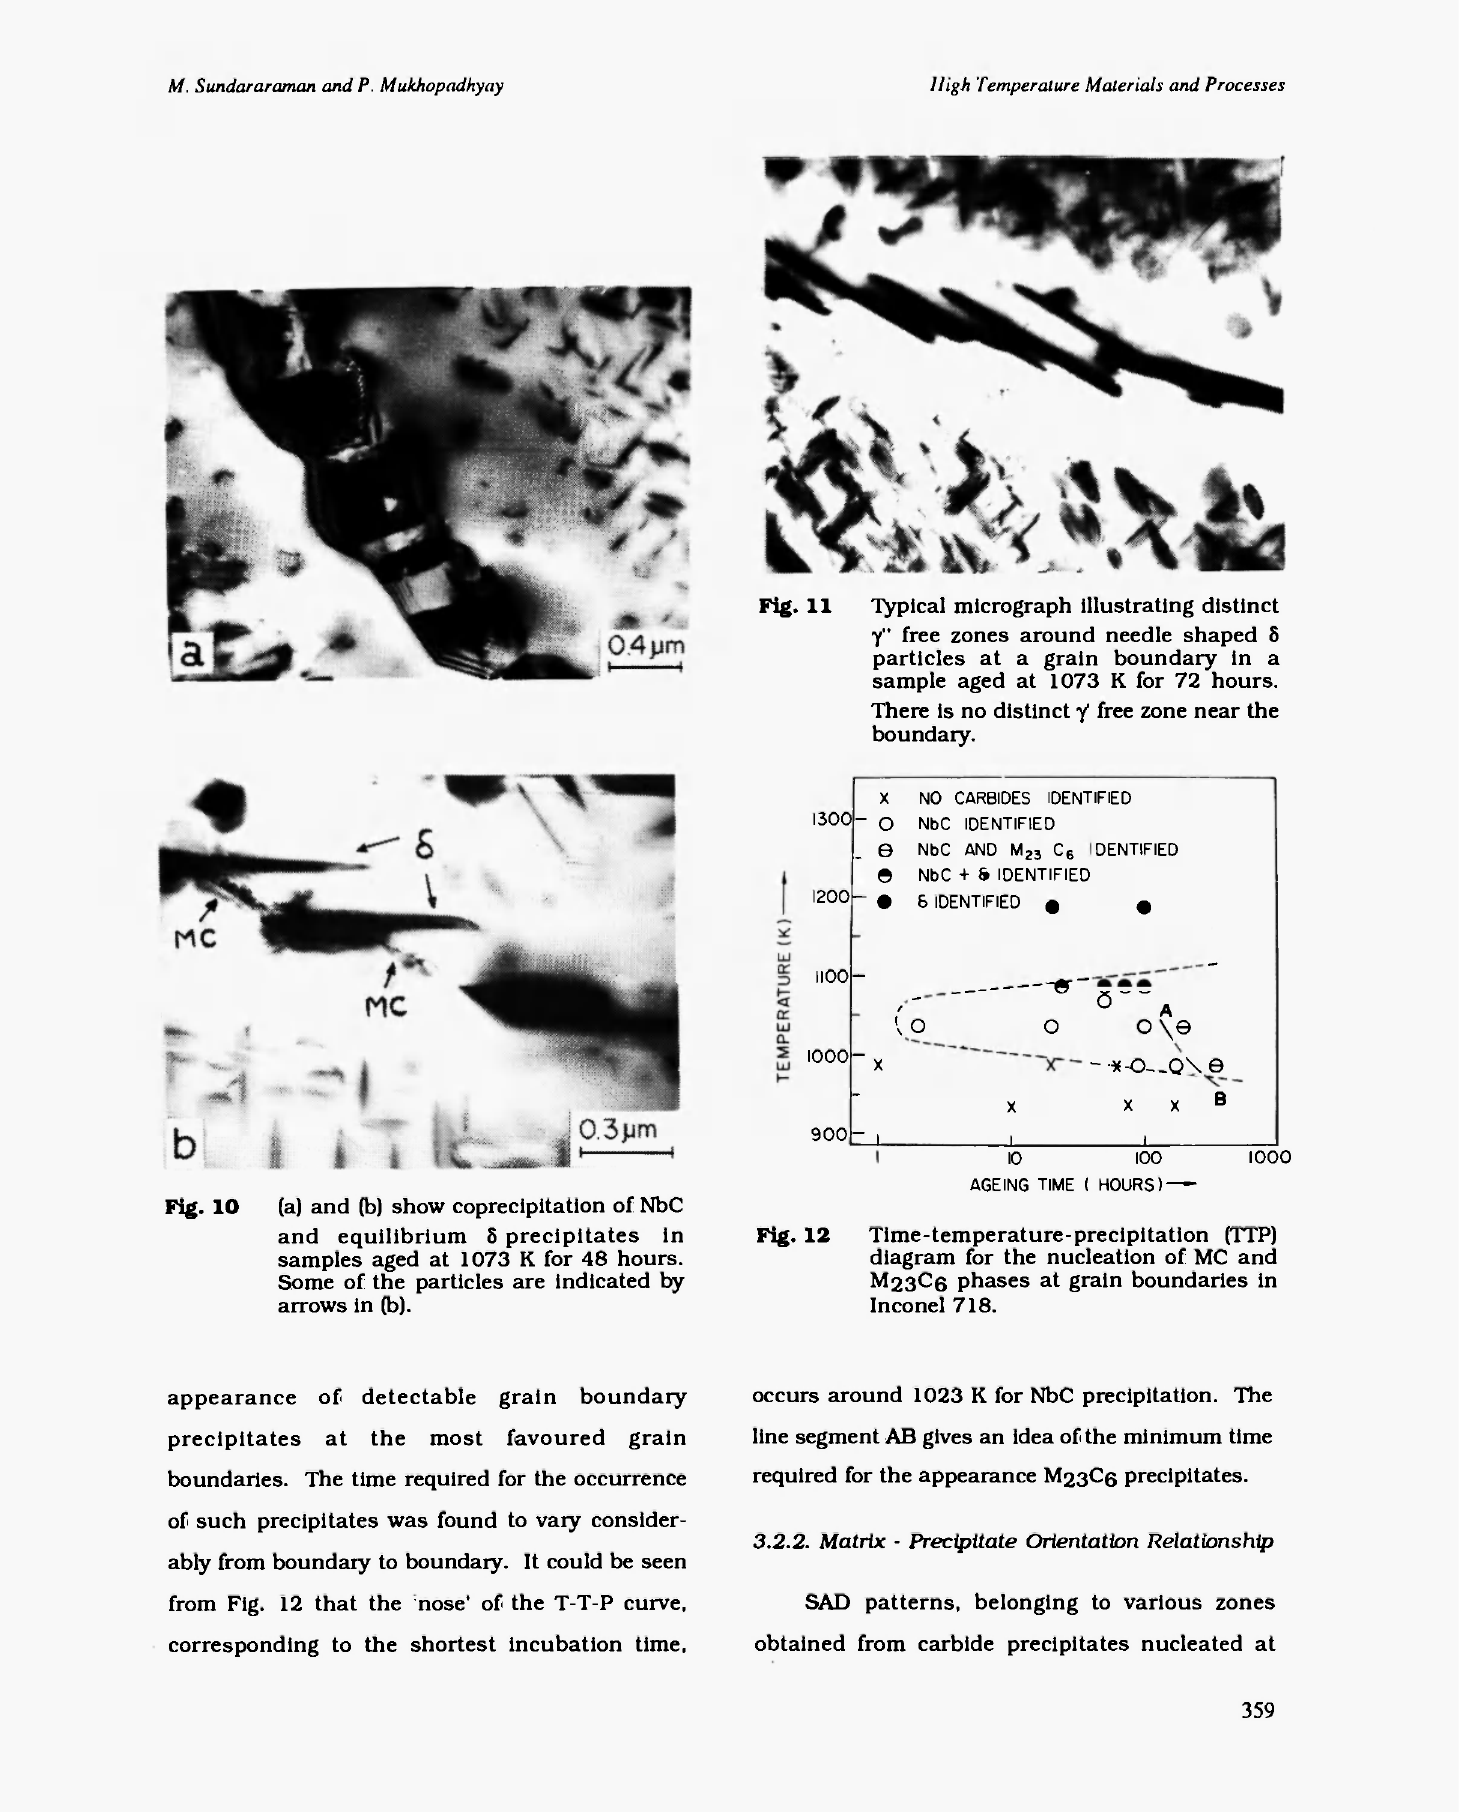
SAD patterns, belonging to various zones obtained from carbide precipitates nucleated